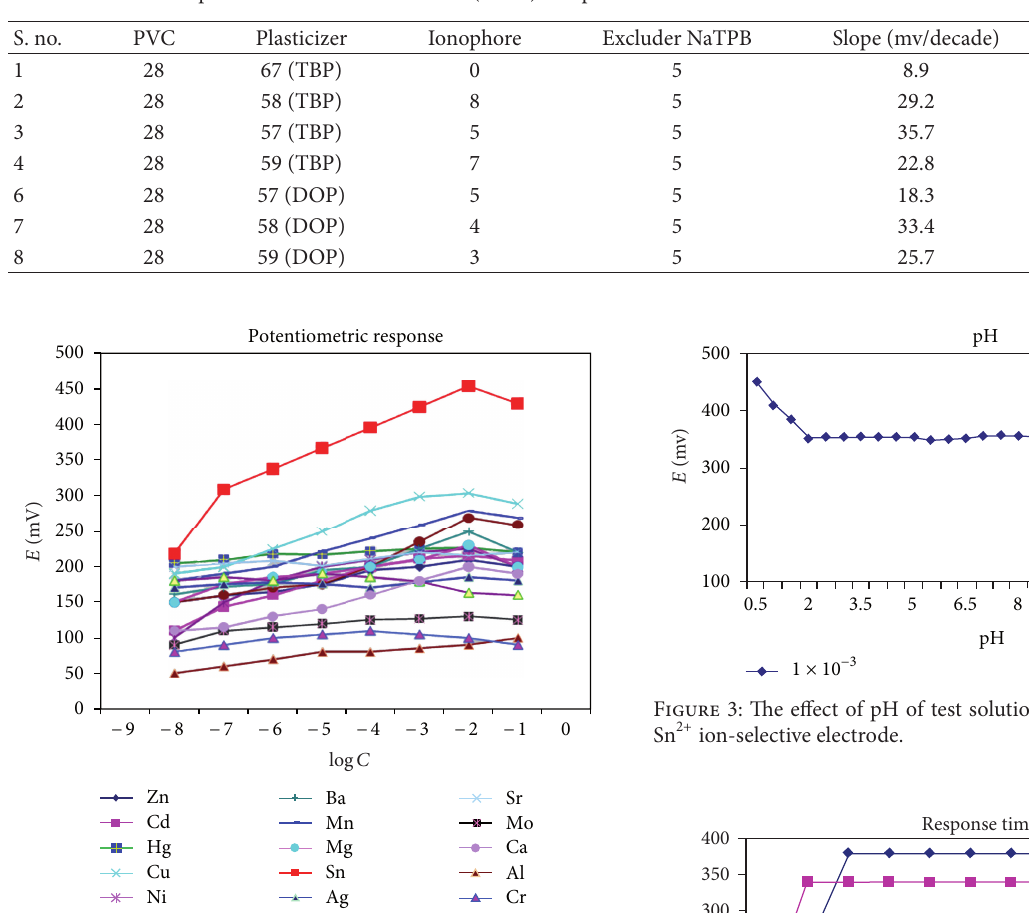
T 2: Composition of PVC membrane of (STSC) and performance characteristics of Sn